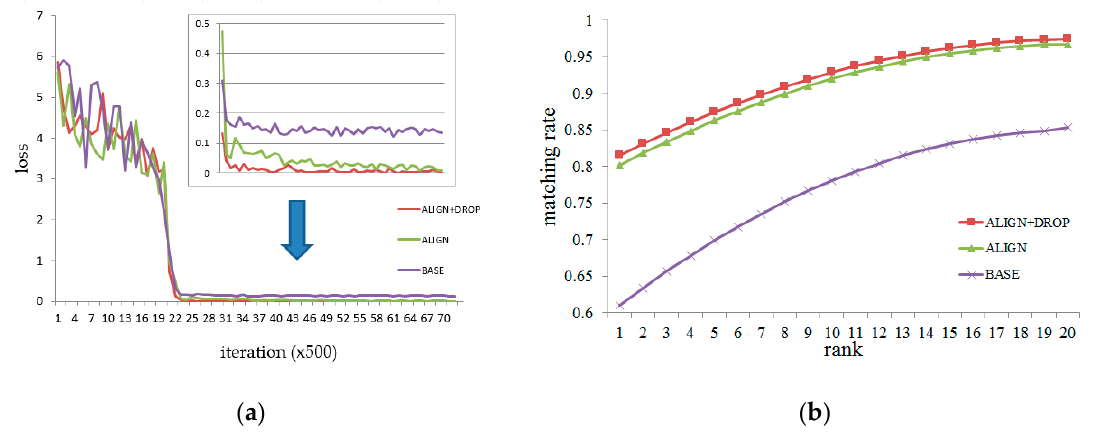
Figure 6. Loss curves and CMC curves. ( a ) Loss curves of BASE, ALIGN and ALIGN +DROP network during training; ( b ) CMC curves of BASE, ALIGN and ALIGN +DROP network during testing.